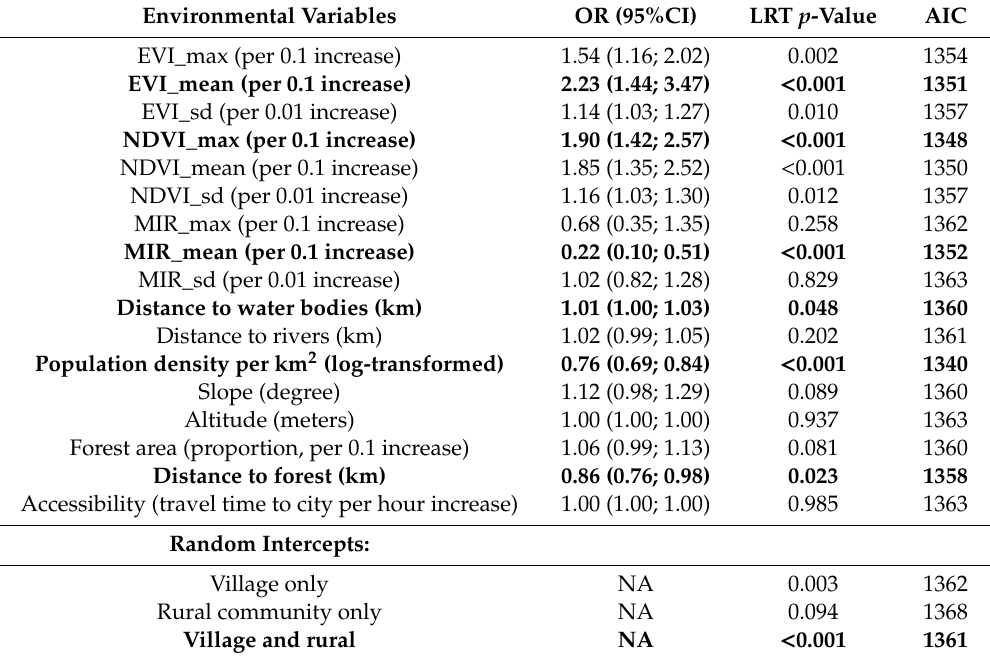
Table 1. Univariable analysis of the association between CHIKV seroprevalence and environmental variables. The models were adjusted for clustering of individuals in villages and rural communities (random intercept).